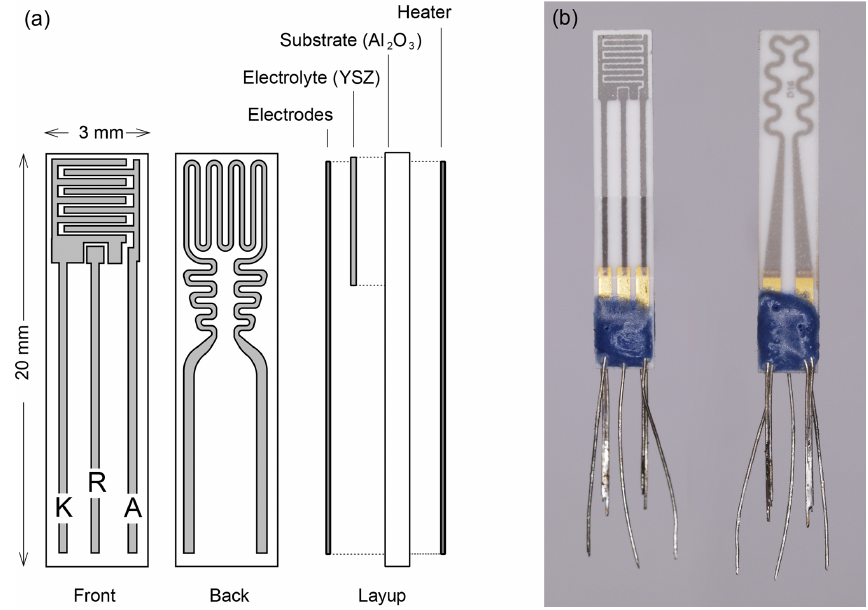
Figure 1. (a) Schematic layout of the three-electrode FIPEX sensors. Front side with interdigitated electrodes, back side with resistance heater. (b) Photo of a screen-printed sensor with platinum electrodes. The leads are sealed with a blue glass layer.